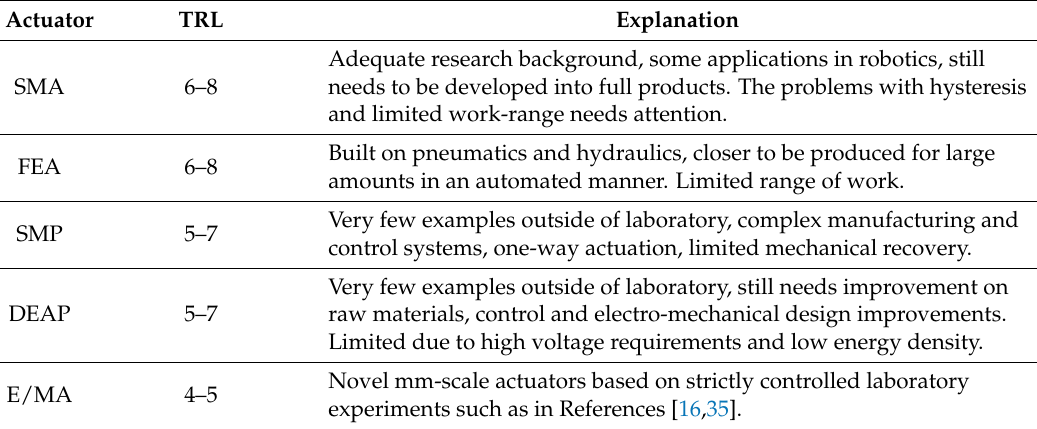
Table 5. Application oriented TRL comparison of soft and novel